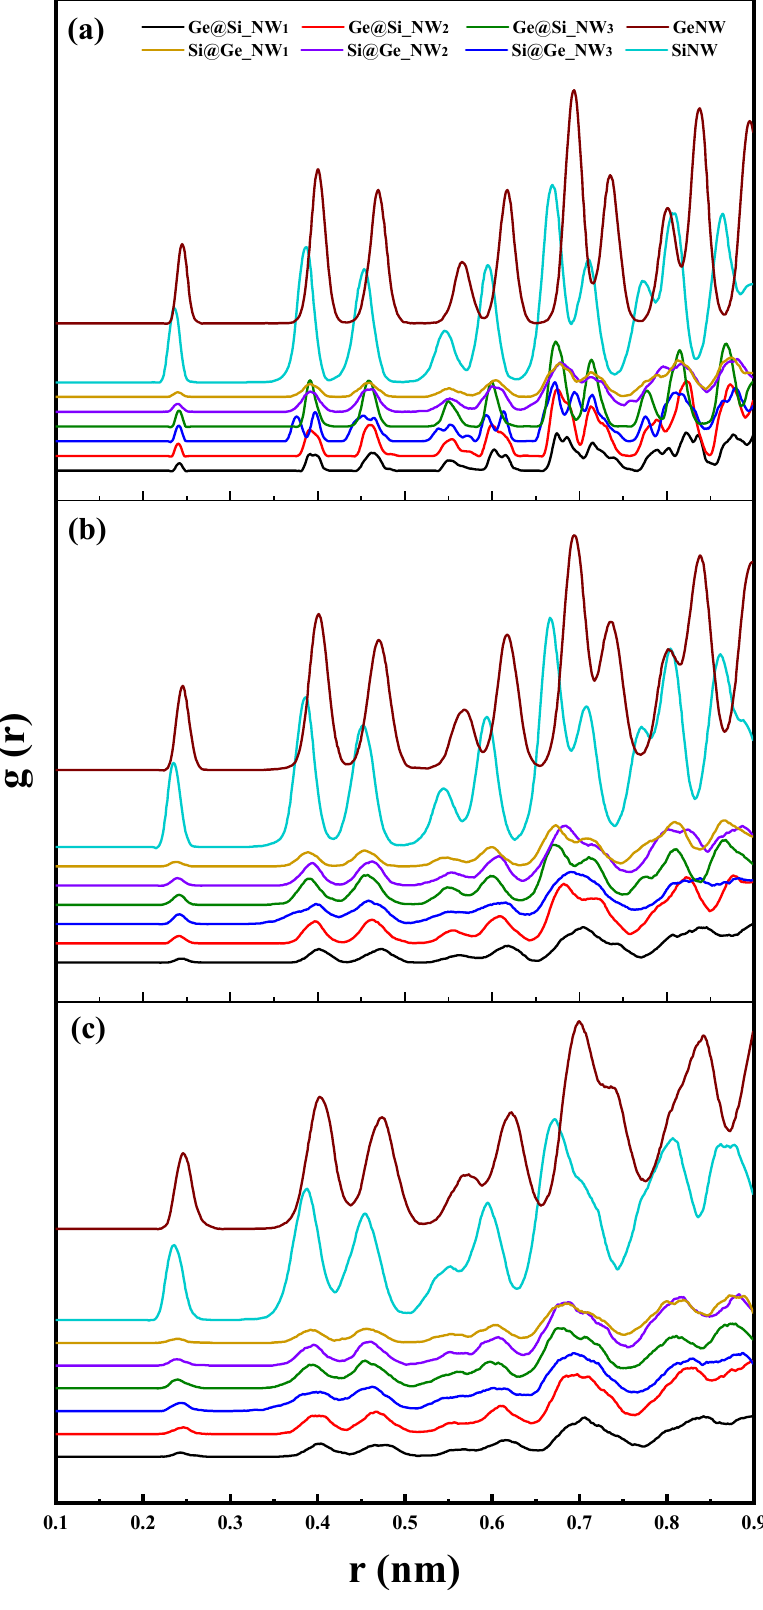
Figure 3. The g(r) of Ge@Si and Si@Ge nanowires with different core–shell ratios after structural relaxation at different temperatures: ( a ) 300 K; ( b ) 450 K; ( c ) 800 K.